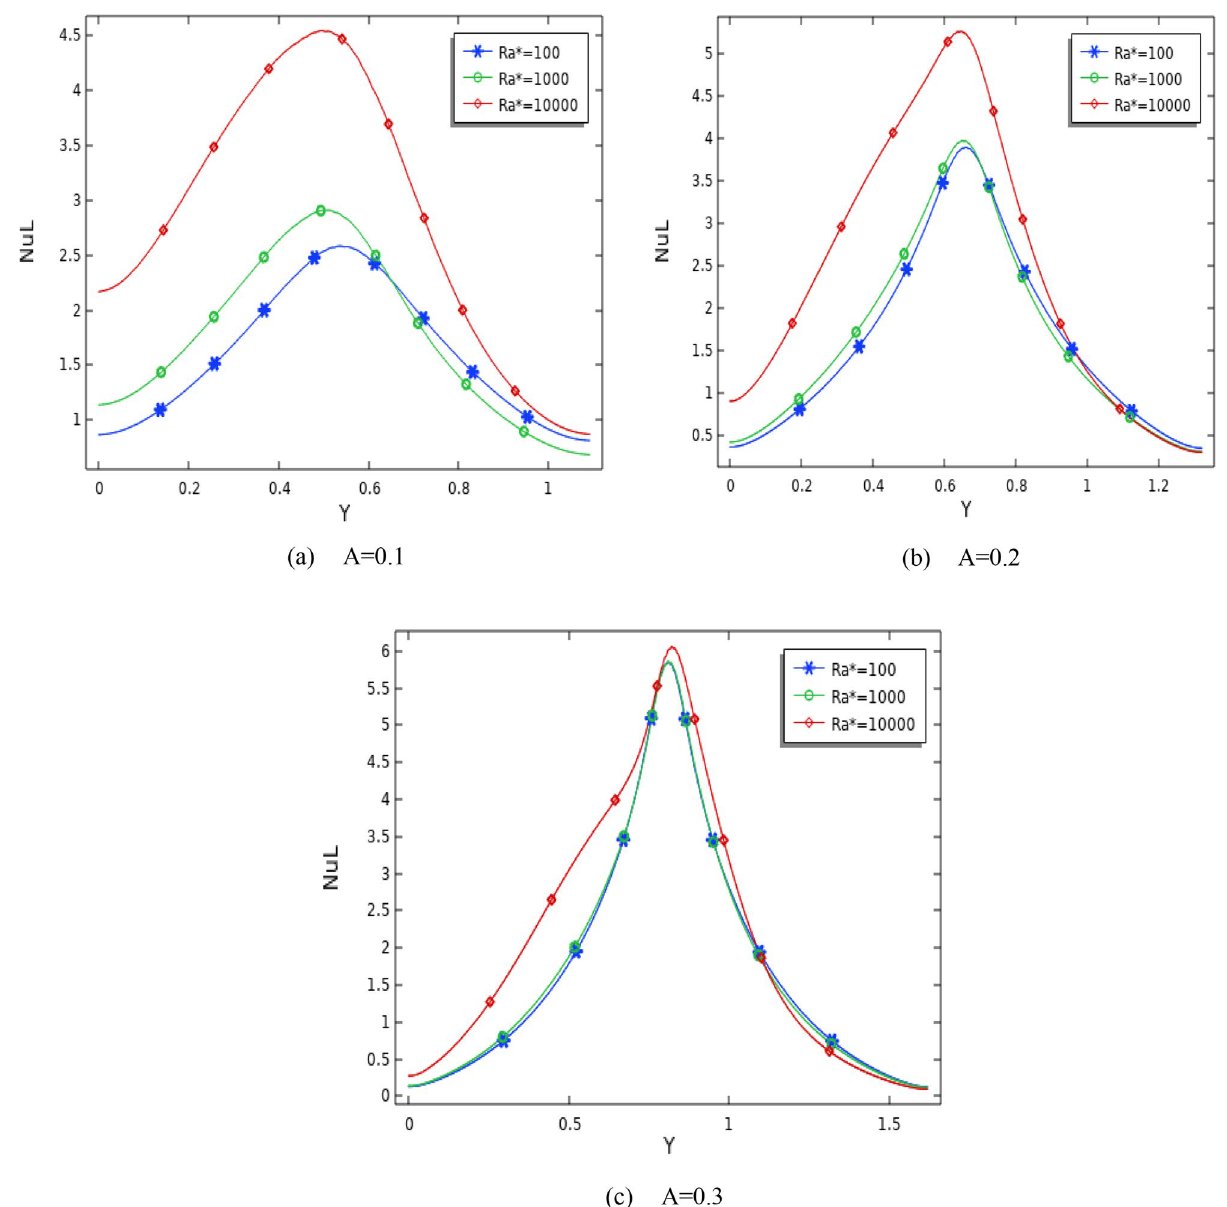
Figure 7. Divergence of Local Nusselt number on the hot wall for various Ra* and Da at number of waves (N = 1), ϕ = 0.01, and ( a ) A = 0.1, ( b ) A = 0.2, and ( c ) A =